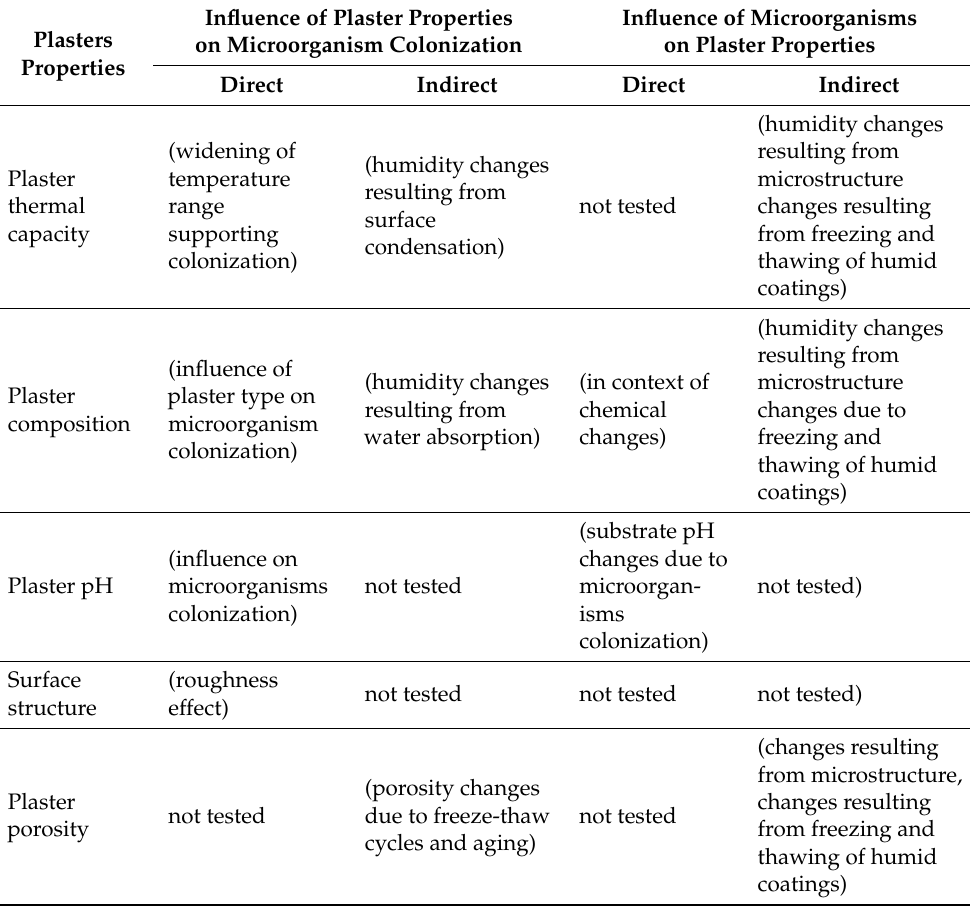
Table 4. Relationship between plaster properties and microbial